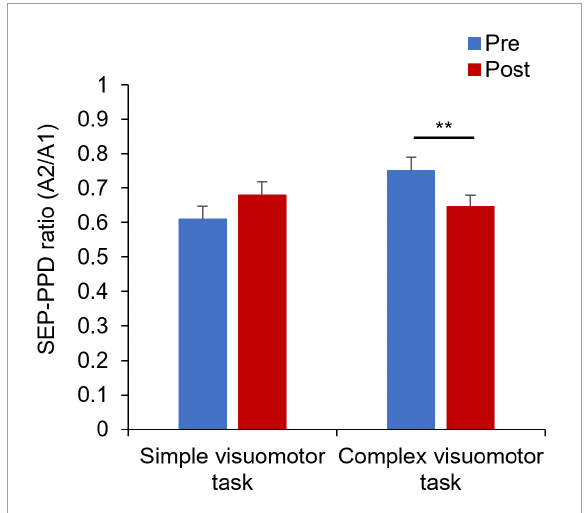
FIGURE8 Changes in the SEP-PPD ratio under each condition. The blue and red boxes show the average SEP-PPD ratio value before and after the intervention, respectively, under each condition. The results indicate that the SEP-PPD ratio decreased after motor learning in the complex visuomotor task. ** p < 0.01 (vs.